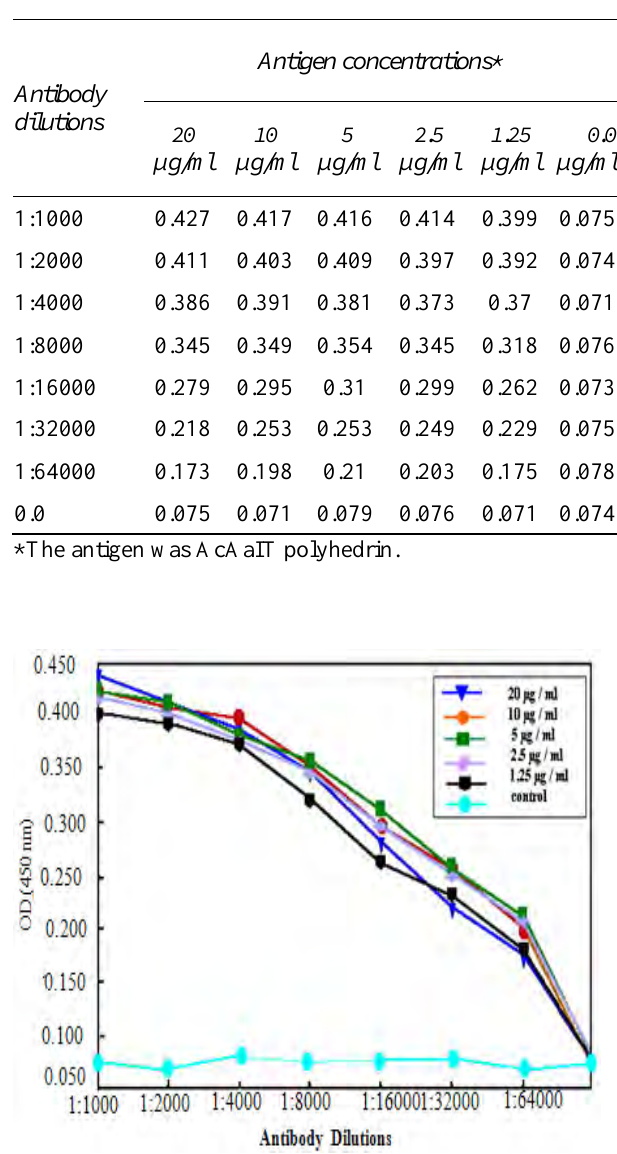
Table 1: Absorbance at 450 nm using different concentrations of antigen and different dilutions of serum antibody.